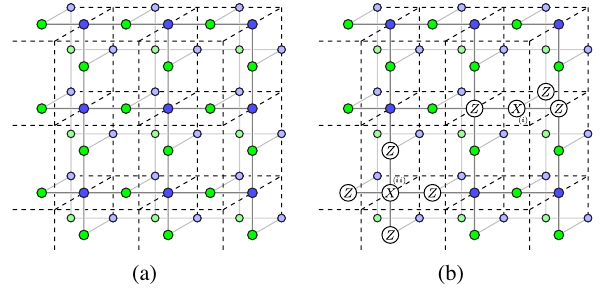
FIG. 8. (a) The lattice at the dual boundary. Primal qubits are depicted in green, while dual qubits are depicted in blue. (b) The dual boundary Hamiltonian H consists of cluster terms, as D depicted by (i) and (ii). Bold lines indicate nearest-neighbor relations between qubits, while dashed lines indicate edges of the ambient cubic lattice.